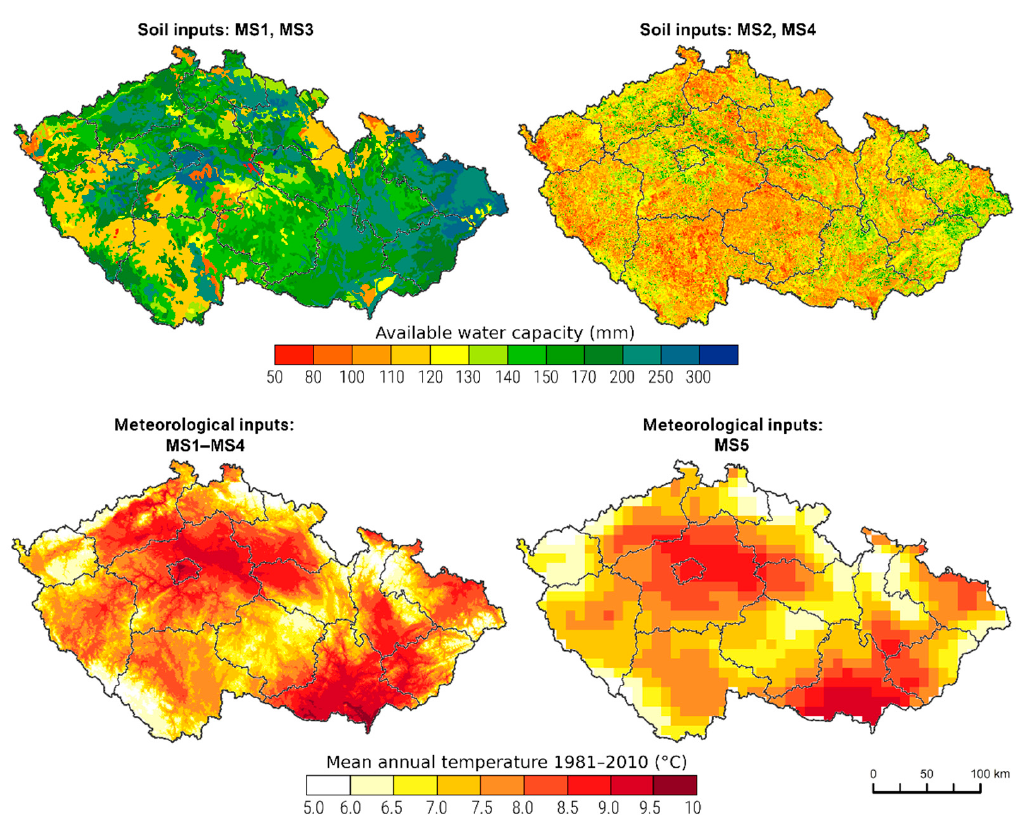
Figure 2. Available water capacity in terms of soil inputs for MS1/MS3 [16] and MS2/MS4 [18] setups, and mean annual air temperature in the Czech Republic according to meteorological inputs for MS1–MS4 (CHMI) and MS5 (ERA5-Land) setups in the 1981–2010 period.